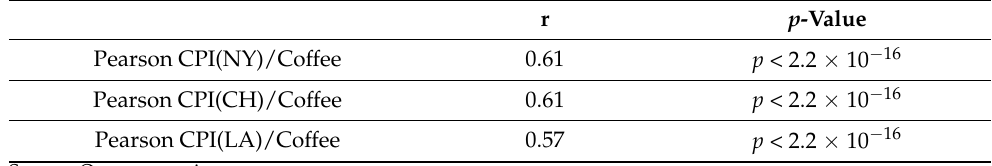
Table 2. Values of Pearson correlation coefficient and p -value.